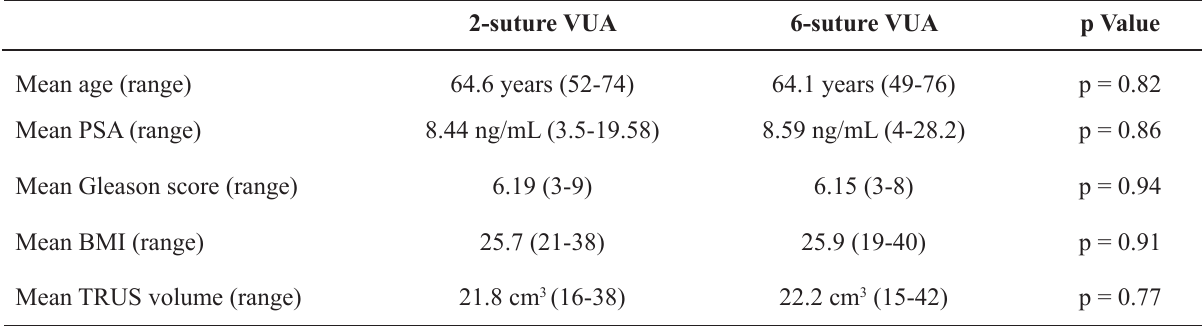
Table 1 – Patient